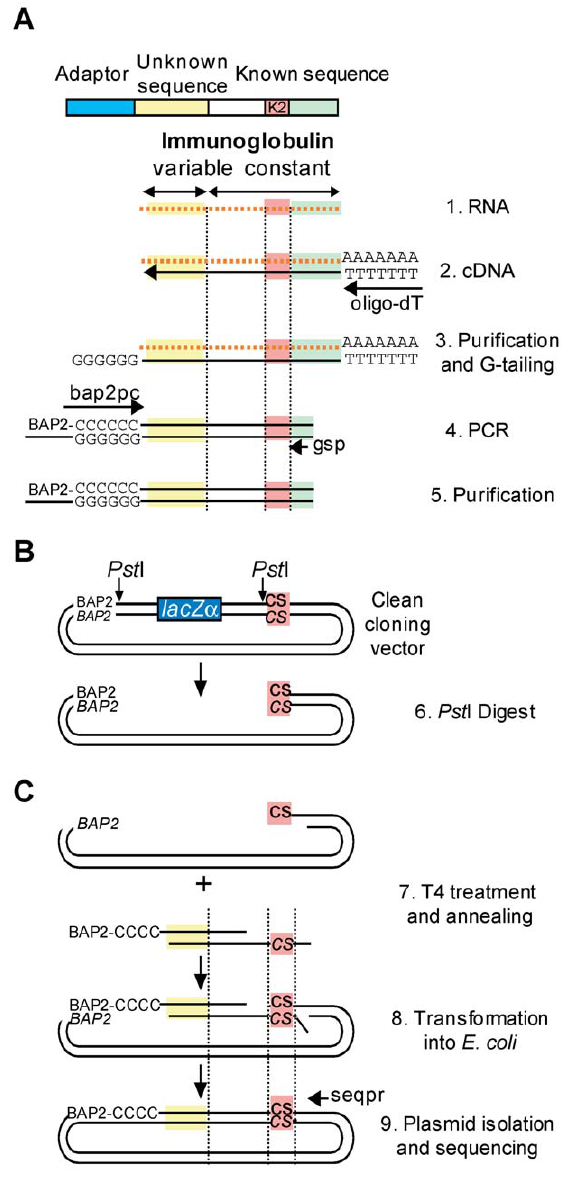
Figure 3. Strategy for amplification and QC cloning of immunoglobulin fragments. ( A ) Amplification of immunoglobulin fragments from non-Hodgkin lymphoma samples. Total RNA extracted from biopsy samples (1) is reverse-transcribed into first strand cDNA using an oligo dT primer (2). The cDNA is column-purified to remove remaining dNTPs, and G-tailed using terminal transferase and dGTP (3). (4) The G-tailed cDNA is used as a template for PCR amplification using a G-tail adaptor primer (bap2 pc) and an immunoglobulin constant region-specific primer (gsp). The PCR product is column-purified to remove the remaining dNTPs (5). ( B ) Preparation of vector for QC cloning. The cloning vector is linearized using the enzyme Pst I. ( C ) The column-purified PCR product and the linearized vector are mixed and treated with T4 DNA polymerase to generate single-stranded ends that are complementary between the vector and insert (7). The mixture is directly transformed into chemo-competent E. coli DH10B cells where the annealed ends of the vector and insert complex are repaired and ligated (8). (9) After cloning, the plasmid is purified and the insert sequenced using a vector specific primer